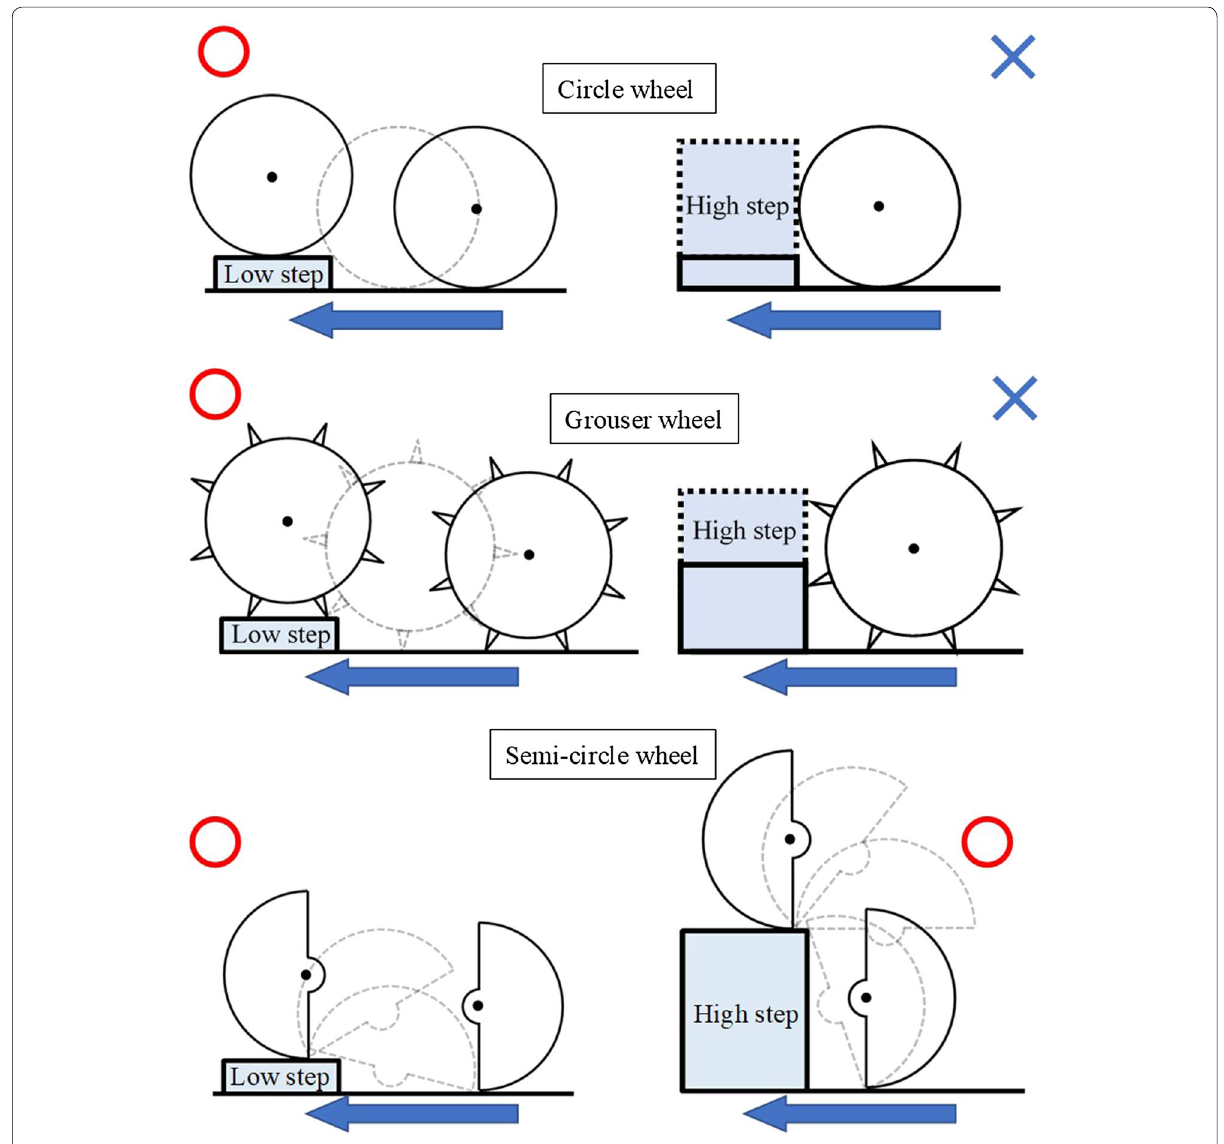
Fig. 1 Comparison of individual